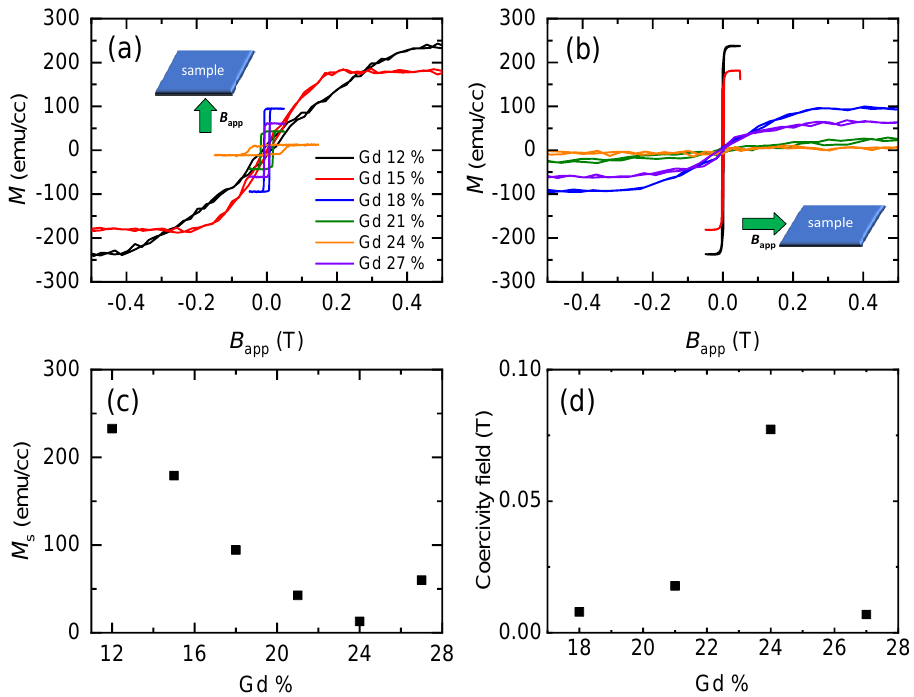
Figure 1. VSM results. Magnetization hysteresis of the Gd x Co 1-x alloy, x from 12% to 27%, applying the magnetic field ( a ) out-of-plane and ( b ) in-plane directions. ( c ) The saturation magnetization of the Gd x Co 1-x alloy. ( d ) The coercivity field of the out-of-plane anisotropy Gd x Co 1-x